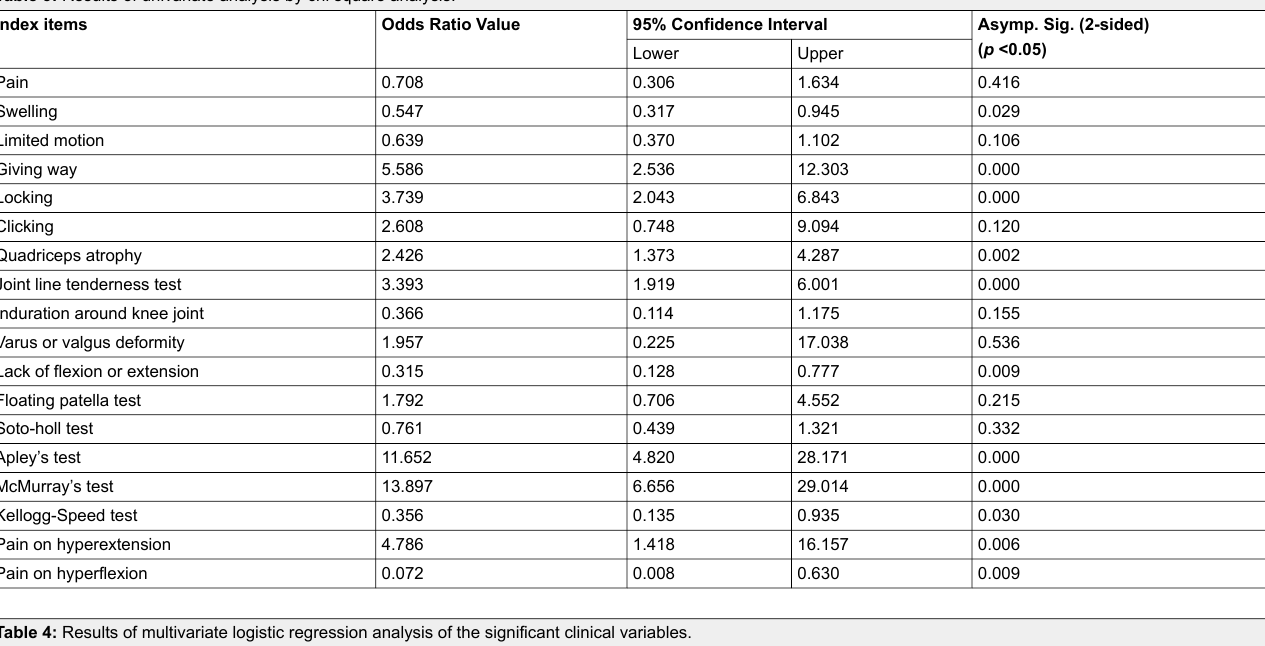
Table 3: Results of univariate analysis by chi square analysis.